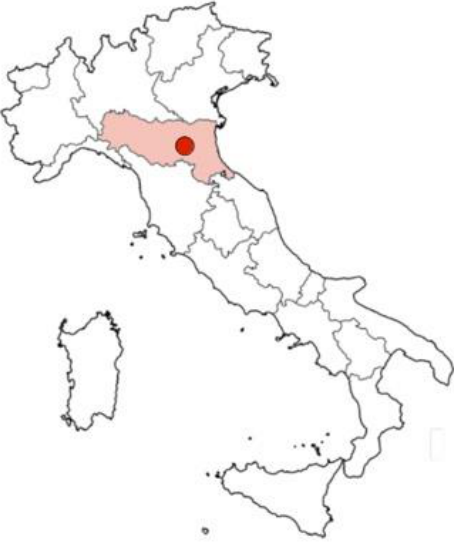
Figure 3. Bologna location within Emilia Romagna region in Italy.